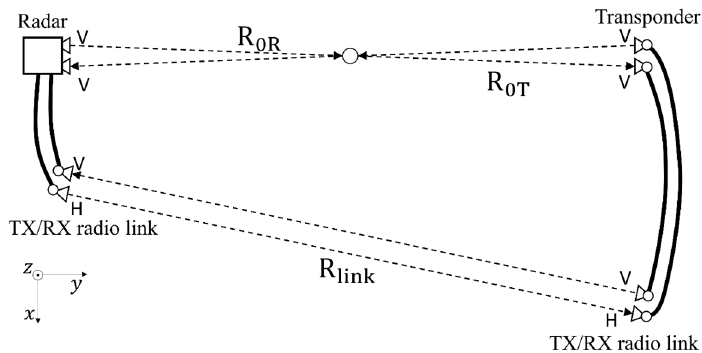
Figure 3. Scheme of a working principle of multi-monostatic interferometric radar with radio link (view form above).